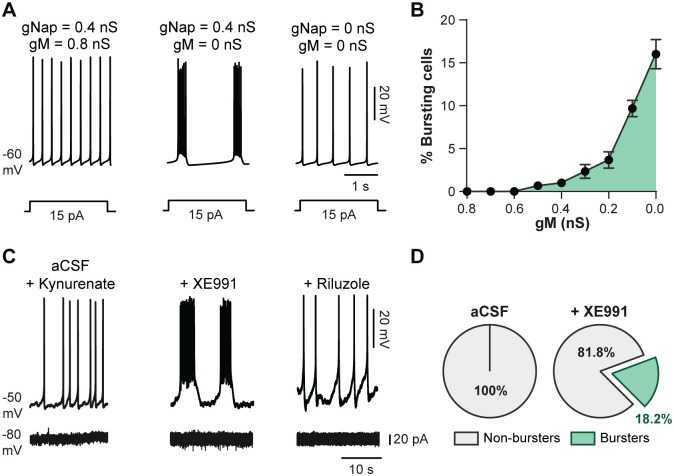
IM regulates the firing pattern of L1–L2 ventromedial interneurons.(A) Typical switch of the firing pattern from spiking to bursting in a single-neuron model when gM was switched “off”; simulated blockade of INaP (gNaP = 0) abolished bursting activity. (B) Dependence of the percentage of bursting cells on gM in the heterogeneous population model of 50 neurons. (C) On top, representative voltage traces of a ventromedial interneuron (L1–L2) intracellularly recorded in the presence of kynurenate (1.5 mM) before (left) and after (middle) bath-applying XE991 (10 μM). A subsequent application of riluzole (5 μM) abolished bursts (right). At bottom, current traces of the cell illustrated and voltage clamped at −80 mV. (D) Proportion of burster and nonburster interneurons before and after bath-applying XE991 (n = 22 cells). Data are mean ± SEM. Underlying numerical values can be found in the S1 Data. aCSF, artificial cerebrospinal fluid; XE991, 10,10-bis(4-pyridinylmethyl)-9(10H)-anthracenone dihydrochloride.